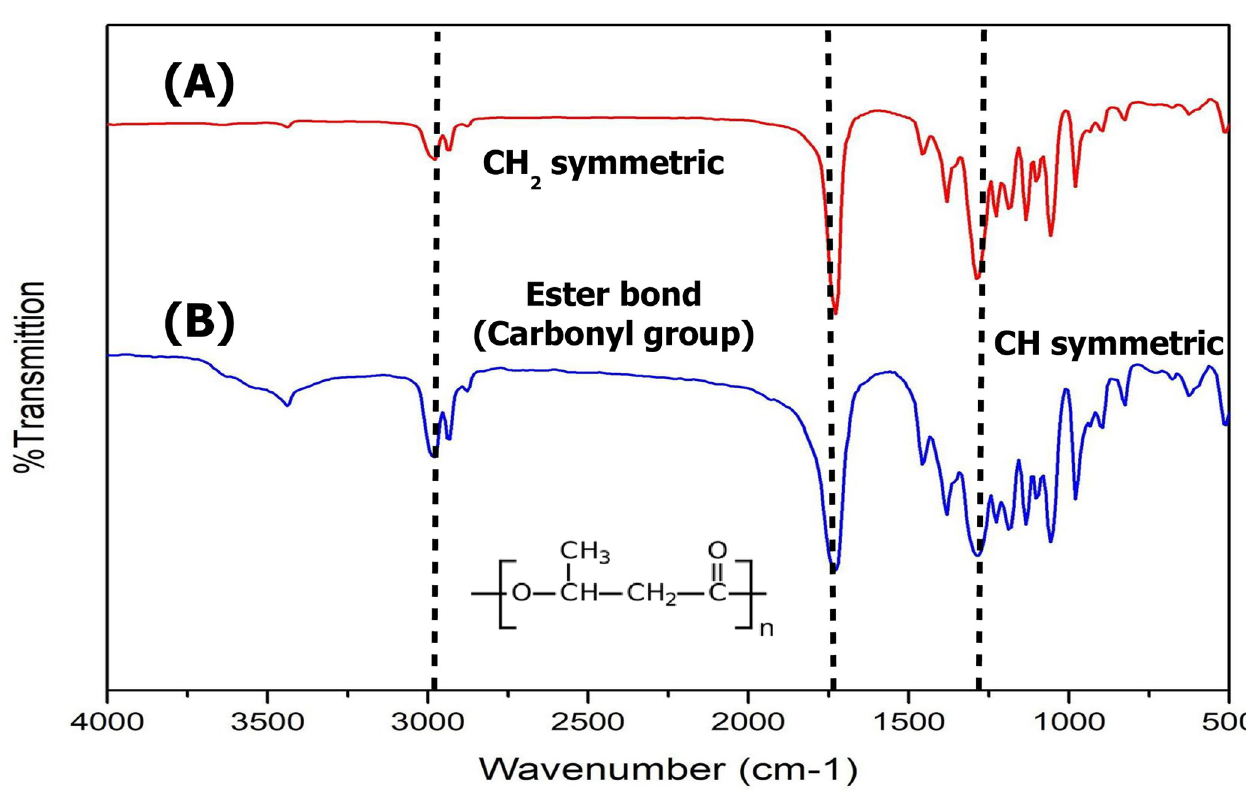
Fig 1. FTIR spectra of (A) commercial PHB (Sigma-Aldrich Corp.) and (B) pure PHB A-04 produced from Cupriavidus necator strain A-04 (B).